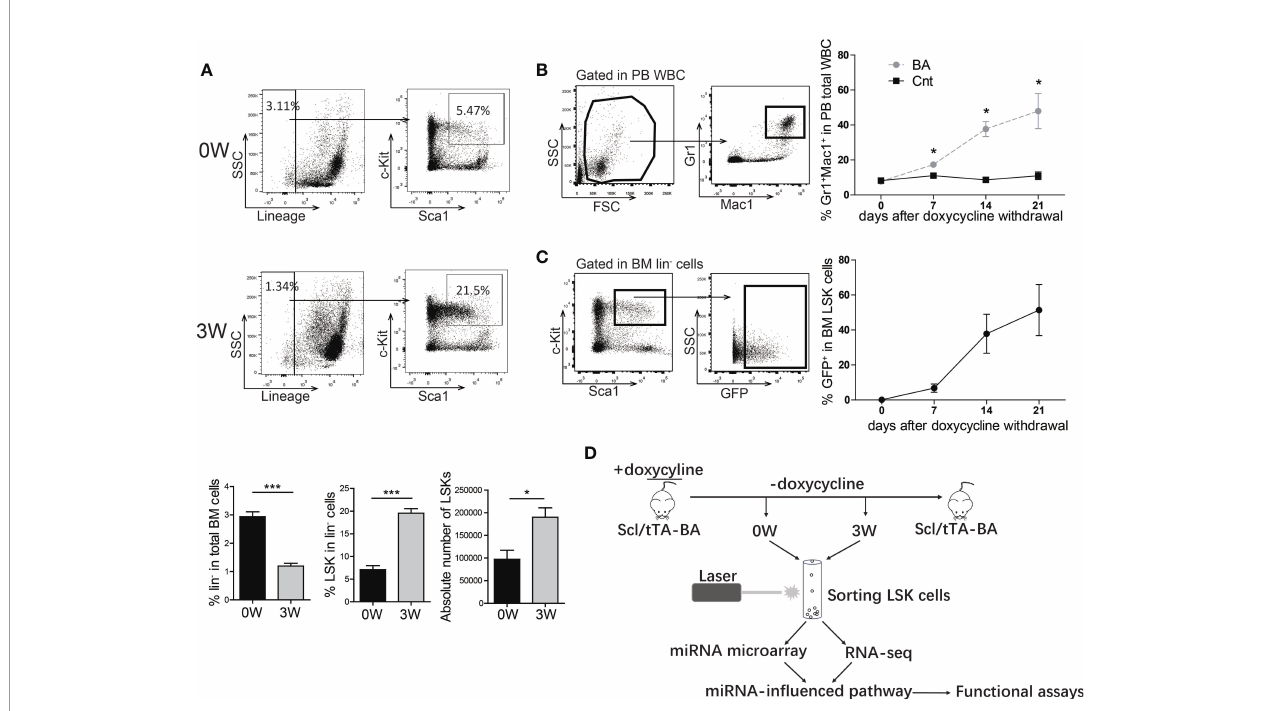
FIGURE 1 | BCR/ABL1 (BA) interferes with the proportion of LSKs in murine bone marrow (BM). (A) Proportion and absolute number analysis of BM Lin - Sca-1 + c- Kit + (LSK) cells in Scl/tTA-BA mice before and after doxycycline withdrawal. (B) Follow-up analysis of granulocyte proportion in peripheral blood (PB) of Scl/tTA-BA mice after doxycycline withdrawal. (C) Follow-up analysis of GFP + cell proportion in LSKs of Scl/tTA-GFP mice. (D) Schematic design of the experiment. Results are mean ± standard error of the mean (SEM), *p < 0.05, ***p < 0.001 (A, B) was assessed by unpaired t